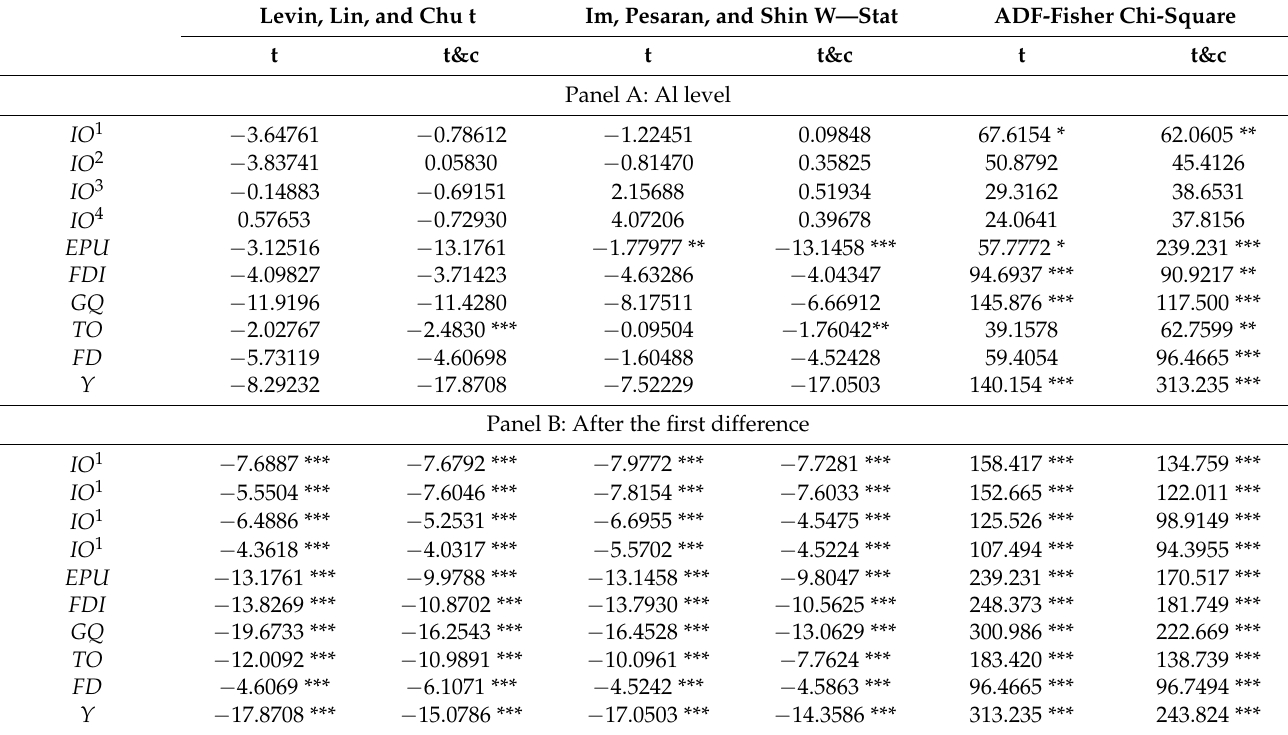
Table 5. Results of panel unit root test.